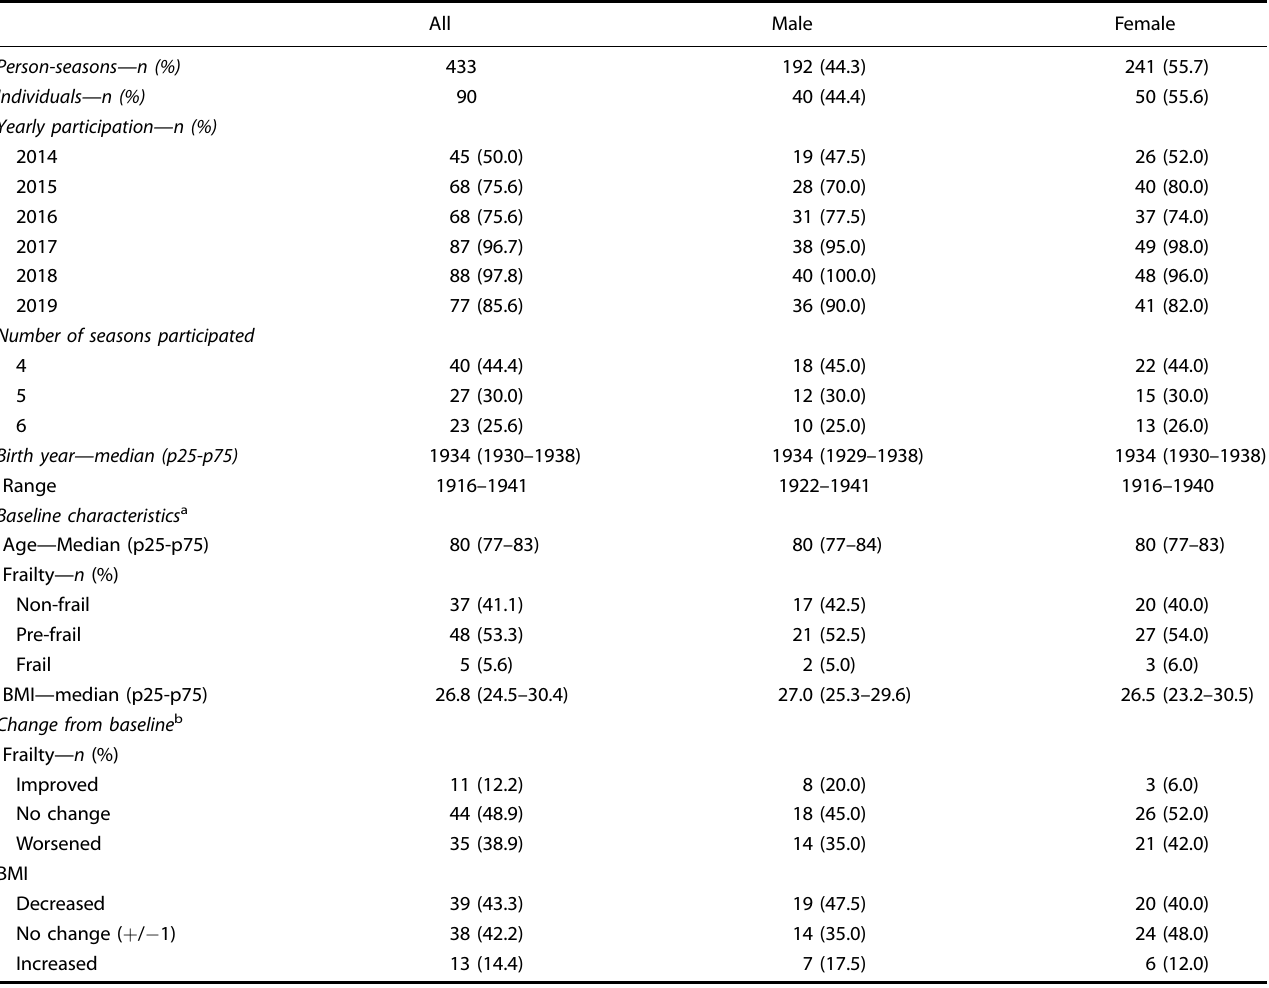
Table 1. Summary of study population